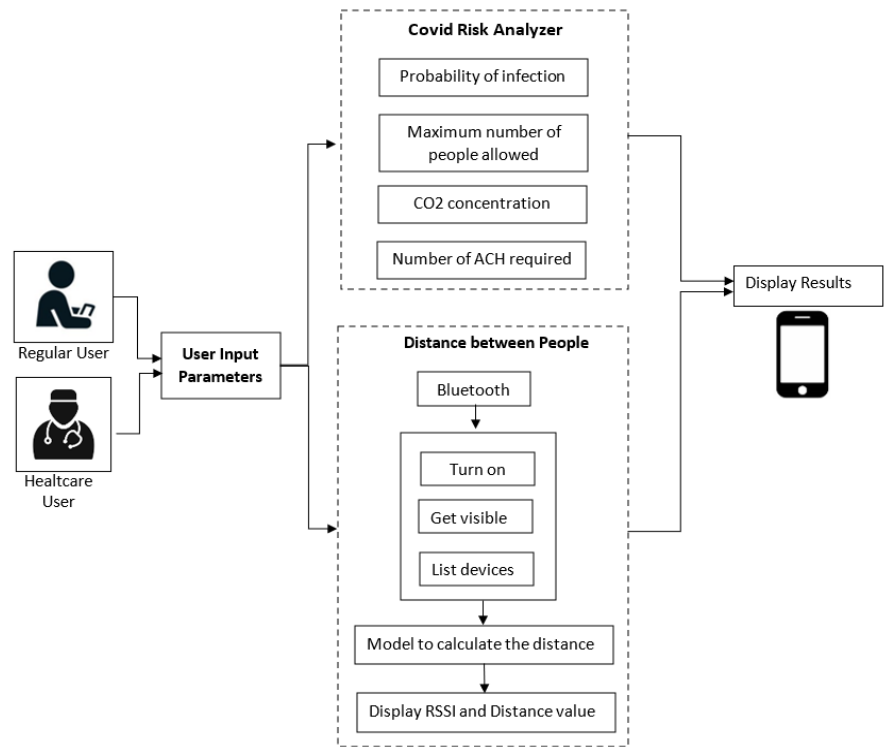
Figure 2. Application architecture.